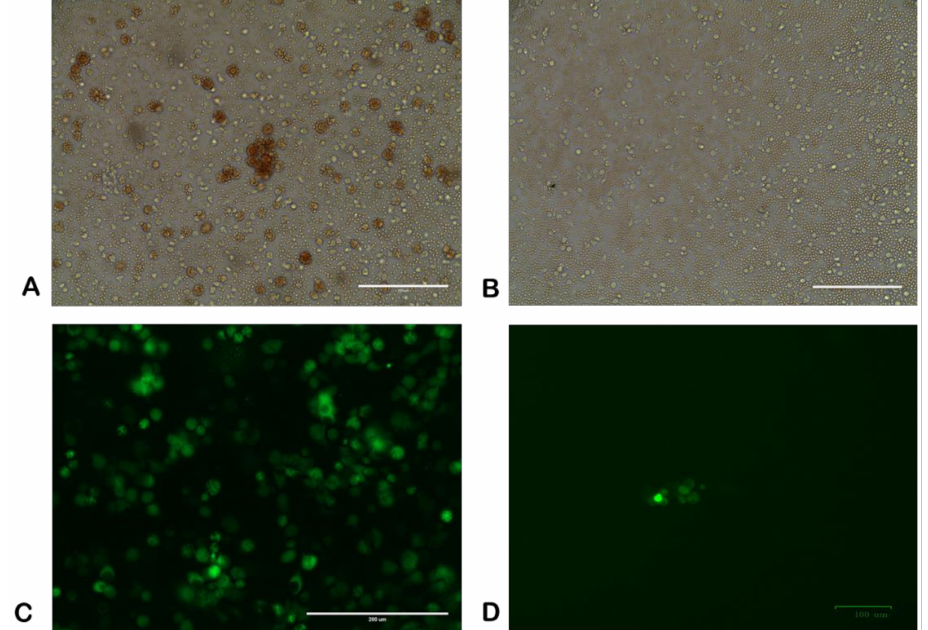
Figure 1. Characterization of ∆ CongoCD2v in cell culture. Hemabsorption assays in primary swine macrophages infected with ( A ) parental Congo-v virus, or ( B ) ∆ CongoCD2v. ( C ) Fluorescent microscopy of COS-1 cells infected with ASFV ∆ CongoCD2v (MOI = 1) at 4 days post-inoculation. ( D ) Fluorescent microscopy of COS-1 cells infected with ASFV ∆ CongoCD2v (10 − 5 dilution) at 3 days post-inoculation (plaque